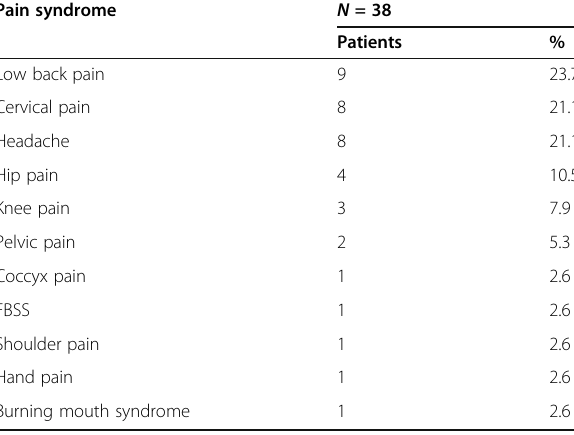
Table 4 Associated pain syndromes in 38 Italian patients